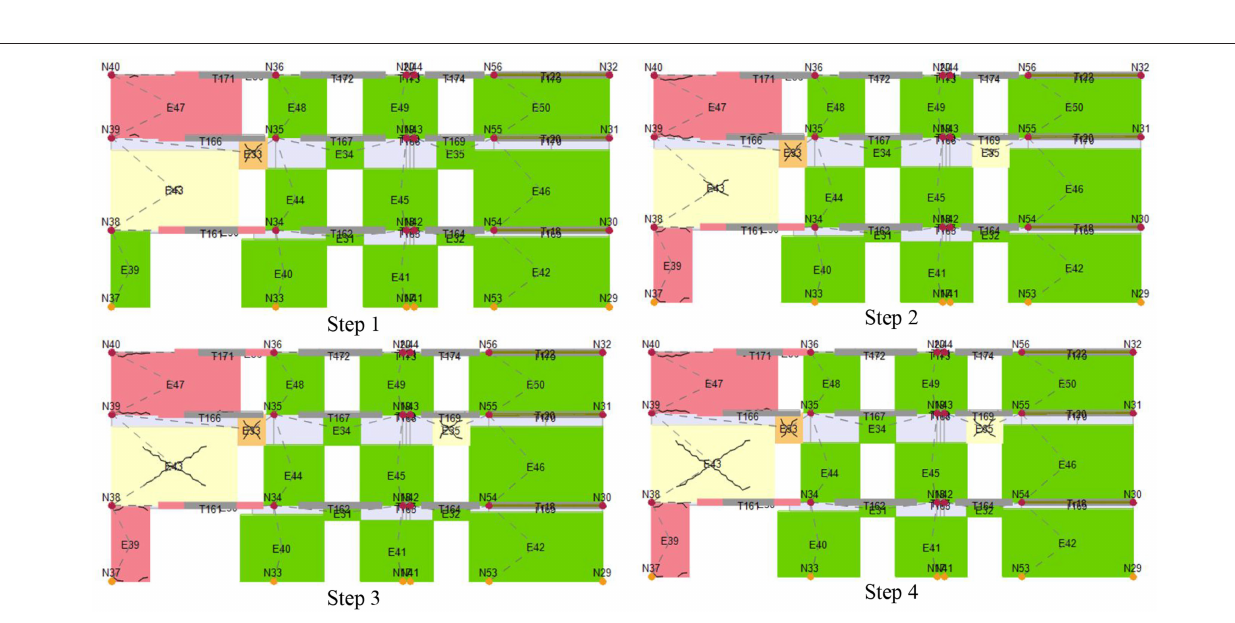
Frontiers in Built Environment | www.frontiersin.org